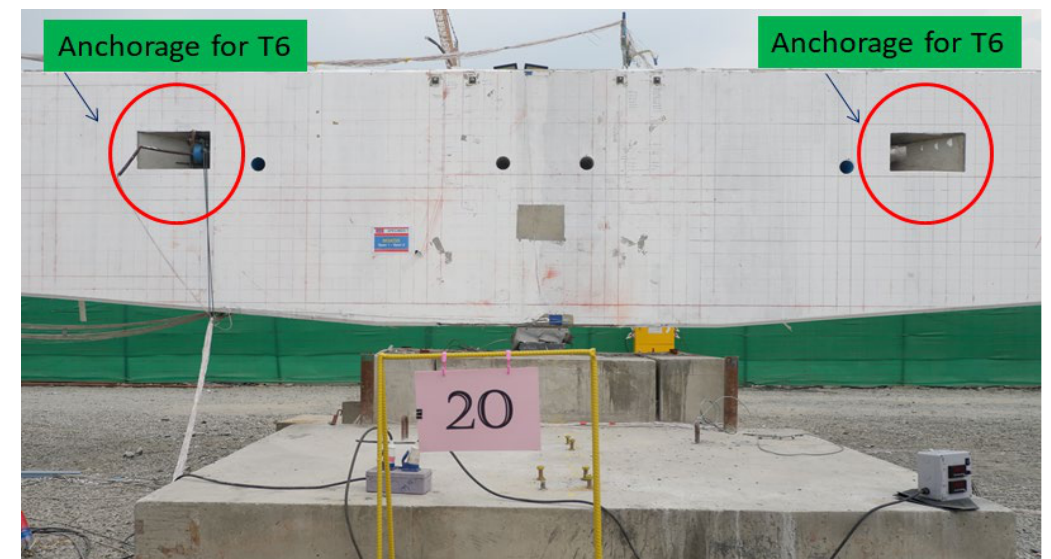
Figure 3. Anchorage for T6.